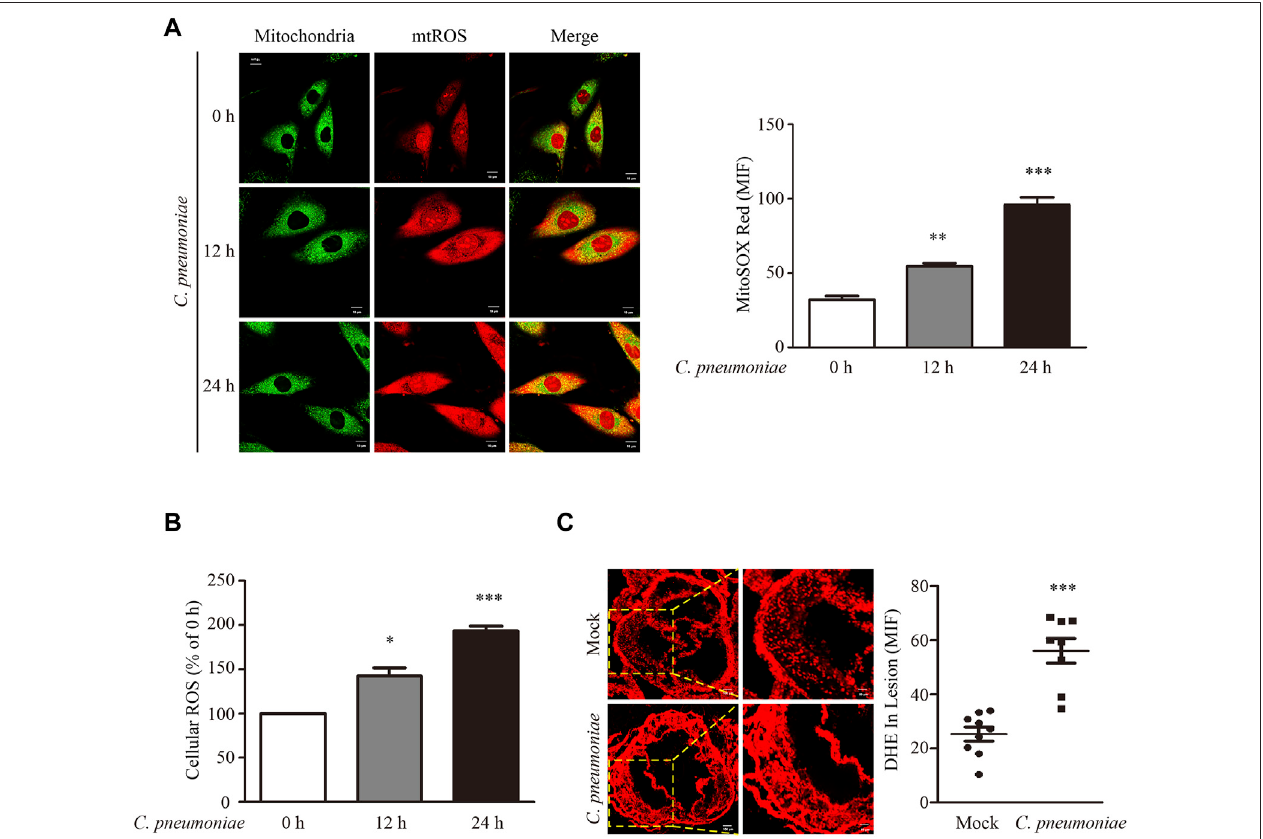
FIGURE2| C.pneumoniae infectionincreasesthelevel ofmtROS inVSMCs. (A,B) VSMCs wereinfected with C.pneumoniae (5×10 5 IFU)for0,12,and 24 h. (A) RepresentativeconfocalmicroscopyimagesofVSMCsthatwerestainedwithMitoSOXRedandMito-TrackerGreenandquanti fi cationofmean fl uorescenceintensityin VSMCs after C. pneumoniae infection. Scale bar: 10 μ M ** p < 0.01, *** p < 0.001, compared with C. pneumoniae infection 0 h, as analyzed by one-way ANOVA. MIF, mean intensity of fl uorescence. (B) Quanti fi cation of the level of cellular ROS in VSMCs infected with C. pneumoniae for the indicated timepoints. * p < 0.05, *** p < 0.001, compared with C. pneumoniae infection 0 h, as analyzed by one-way ANOVA. (C) ApoE -/- mice ( n = 9) were infected intranasally with 40 μ l sucrose-phosphate- glutamate (SPG) buffer (pH 7.2) containing C. pneumoniae (2 × 10 7 IFU). For the mock infection, ApoE -/- mice ( n = 8) were intranasally administrated with SPG. All mice were analyzed after 6 weeks of Western diet. ROS level was assessed by Dihydroethidium (DHE) in the lesions of aortic sinus. Scale bar: 100 μ M (Left), 50 μ M (Right). *** p < 0.001, compared with mock infection, as analyzed by Student ’ s t -test.